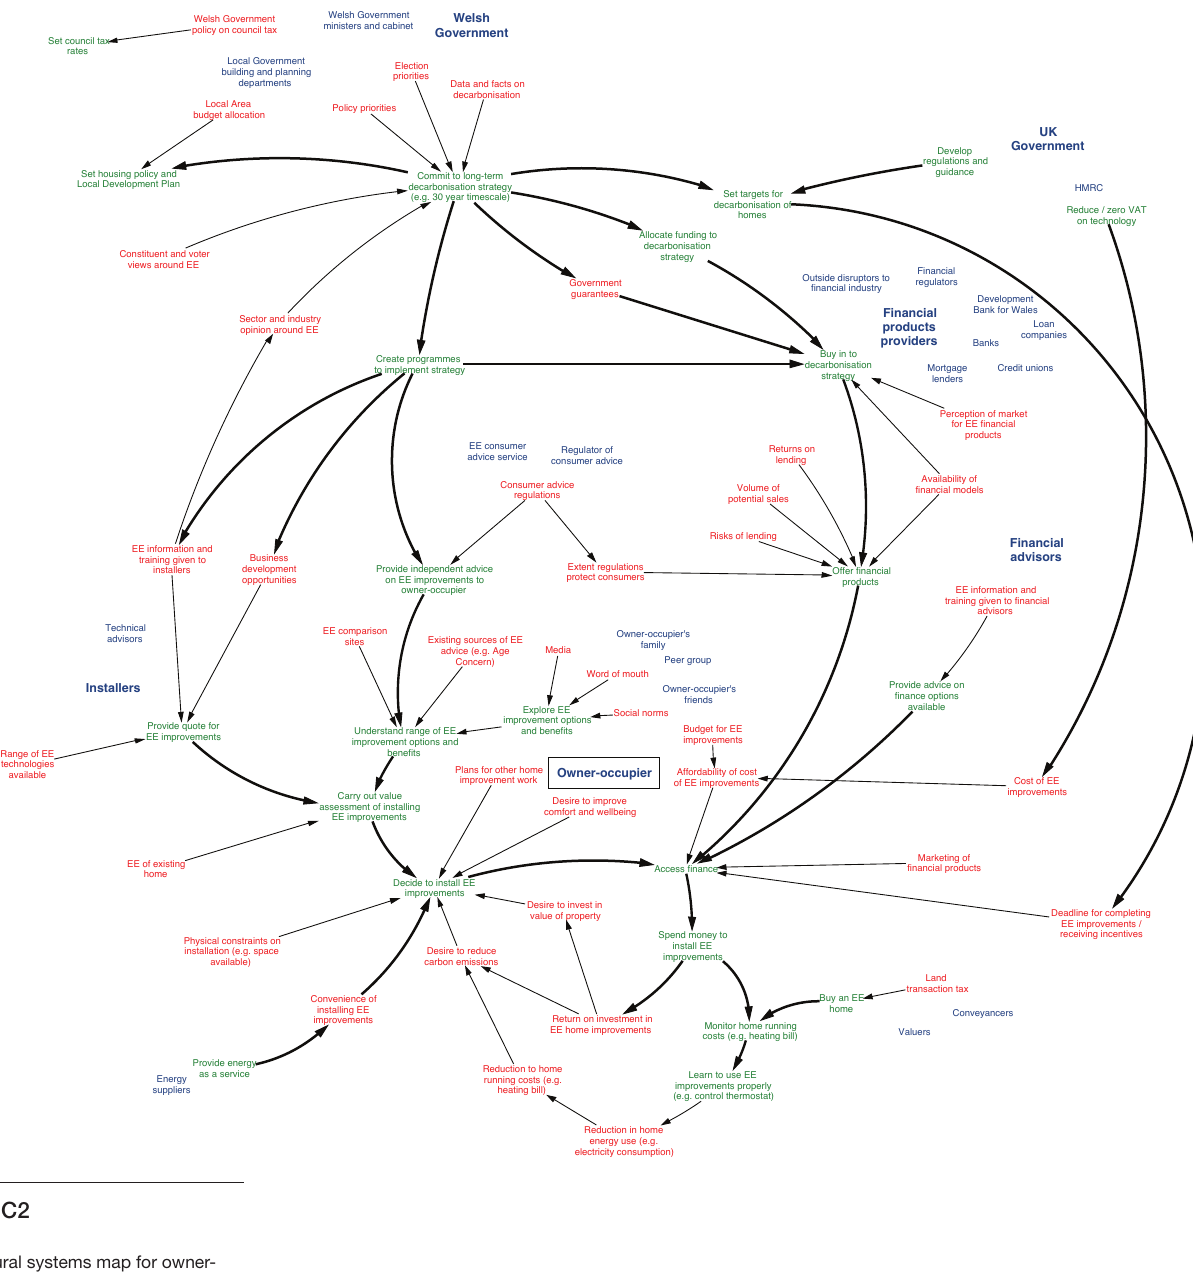
Behavioural systems map for owner- occupiers (draft 1). Note. This figure shows a draft BSM for the system of decarbonising homes owned by owner-occupiers. Actors are shown in blue text. Behaviours are shown in green text. Influences on behaviour are shown in red text. Arrows are used to show positive causal links identified among behaviours and influences on